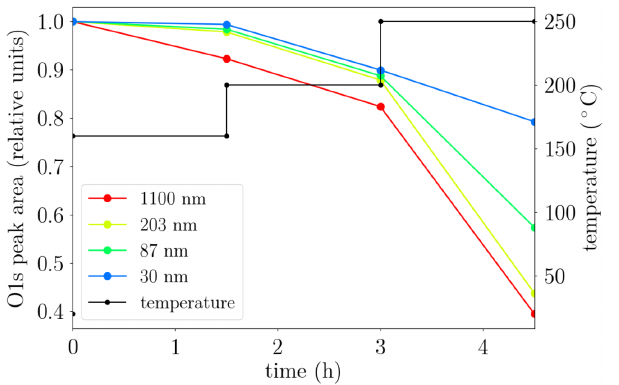
FIG. 8. Activation performance: reduction of the area of the oxygen peak from the XPS spectrum after the fourth activation cycle.